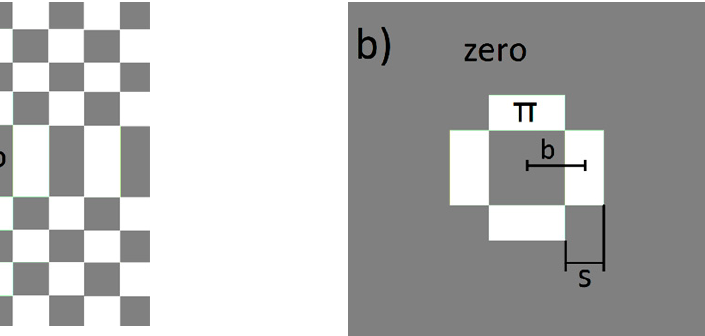
Figure 1. ( a ) Principle phase distribution of sinc(x,y) function; ( b ) First inner phase change of sinc(x,y) function (coordinate origin in the center).